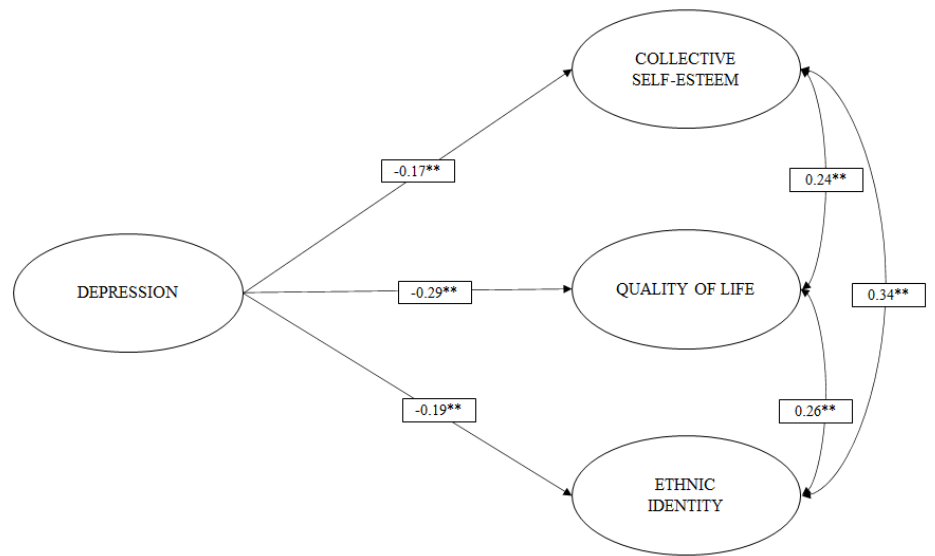
Figure 2. M7 structural model where depression exerts an effect on collective self-esteem, ethnic identity, and QoL. The analysis controlled for the effects of years of stay, sex, and age. * p < 0.05; ** p < 0.001.